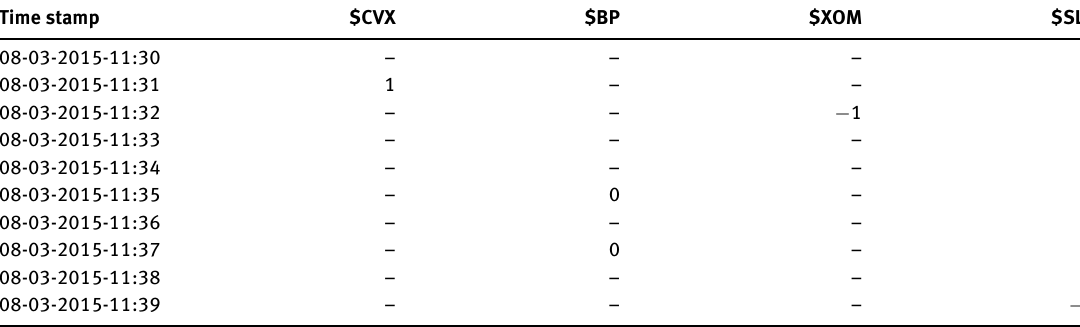
Table 5: Event Matrix as Input for Trading-Minute